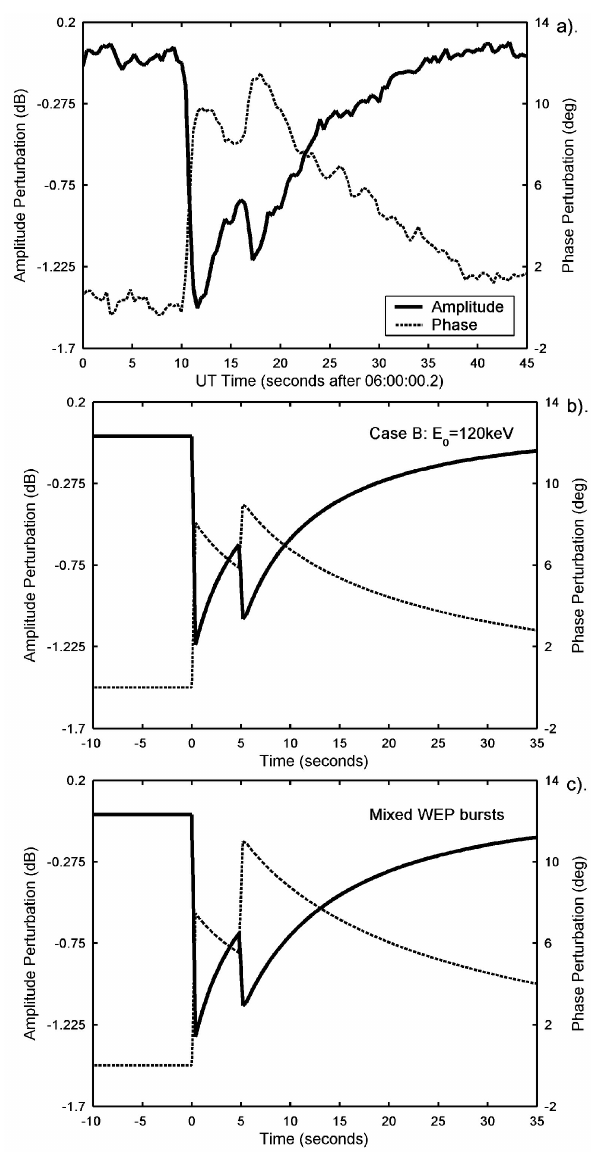
Fig. 9. Examination of the decay of two closely spaced WEP pulses producing a double Trimpi event. (a) Experimentally observed dou- ble Trimpi event, detected on NPM received at Faraday. (b) Calcu- lated Trimpi perturbation caused by a case B WEP burst followed by another, smaller case B WEP burst. (c) As panel (b) but for a case B WEP burst followed by case A